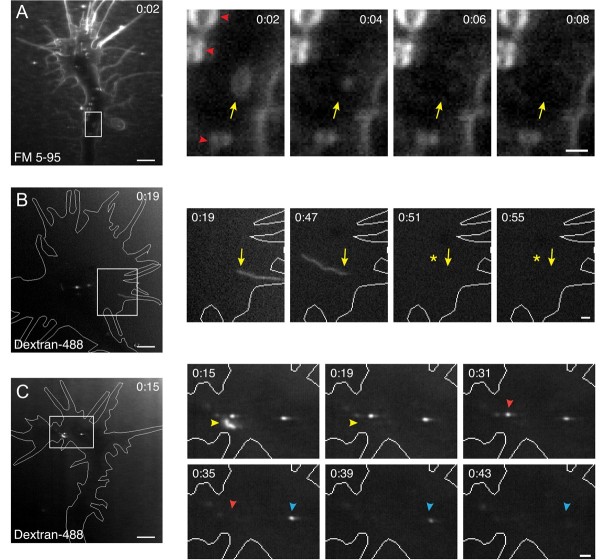
Vacuole and tubule unloading or recycling back to the plasma membrane. (A) Time-lapse confocal images of FM 5-95 internalization show the disappearance of a vacuole in the growth cone central domain. Focally applied FM 5-95 (applied at 0:00) immediately incorporates into several vacuoles (0:02). In subsequent frames, one vacuole narrows (yellow arrows, 0:04) and later disappears (0:06 to 0:08). Note that the size and location of other nearby vacuoles remains unchanged (red arrowheads). (B) Time-lapse confocal images of fluorescent dextran internalization show sudden dye unloading by an elongated tubule in the growth cone periphery (yellow static arrows). The dextran pulse was applied at 0:00 and washed away from 0:10 to 0:15. Note that the labeled tubule disappears within 40 to 50 s of forming (0:51, yellow asterisk). (C) Time-lapse confocal images show rapid unloading of dextran-containing vesicles. The focal pulse was applied and washed away as in (B). Within 20 to 30 s of vesicle formation, nascent vesicles (yellow, red, blue static arrowheads) begin to unload dye. For all examples (A-C), the boxed regions in the left panels are shown at higher magnification on the right and the time after the focal dye pulse (minutes:seconds) is indicated in each frame. Time-lapse movies for (A-C) are shown in Additional file 14. Scale bars, 5 μm (left), 1 μm (right).